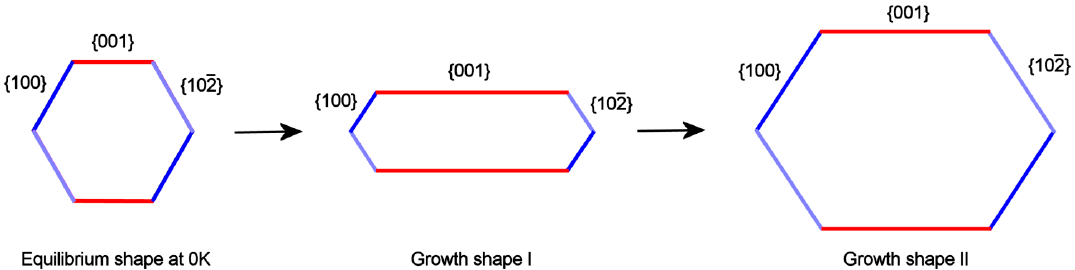
Figure 4. Sketch of a monoclinic P2 1 /c HAp crystal viewed along the OH channels direction. The equilibrium shape at 0 K is clearly pseudo-hexagonal, with the two {100} and {102} forms showing a quasi-identical surface profile (left side). The growth shape I does occur when the supersaturation is high (early stages of growth in a closed system), owing to the anisotropy of the growth kinetics between the {001} pinacoid and the two kinetically close {100} and {102} forms (center). The growth shape II, tending to the pseudo-hexagonality, is recovered when all the growth isotherms intersect, at a critical supersaturation value or when the system approaches the equilibrium (right side).